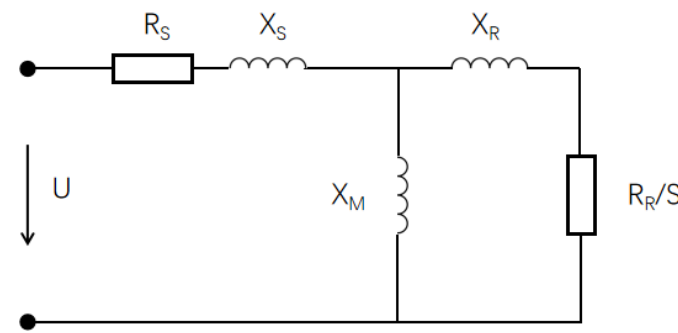
Figure 3. Motor equivalent circuit diagram.